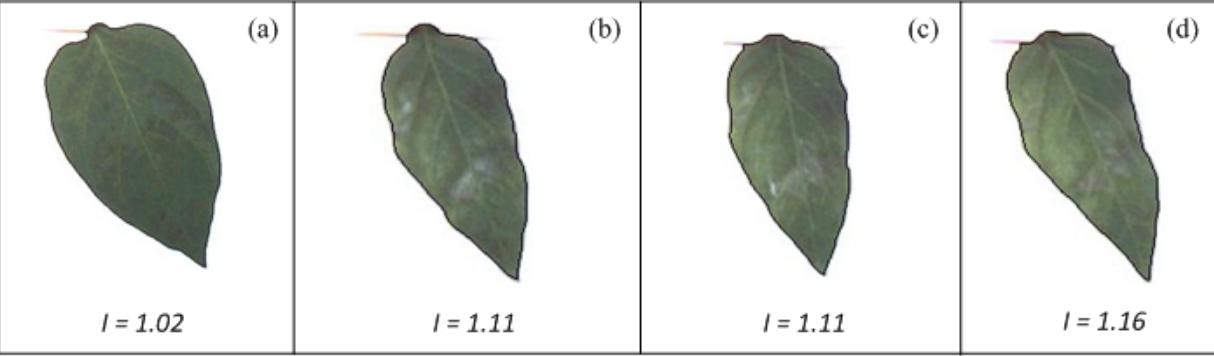
lowest deformation index. ( b ) and ( c ) Leaves with intermediate deformation index. ( d ) Leaf with the highest deformation index.